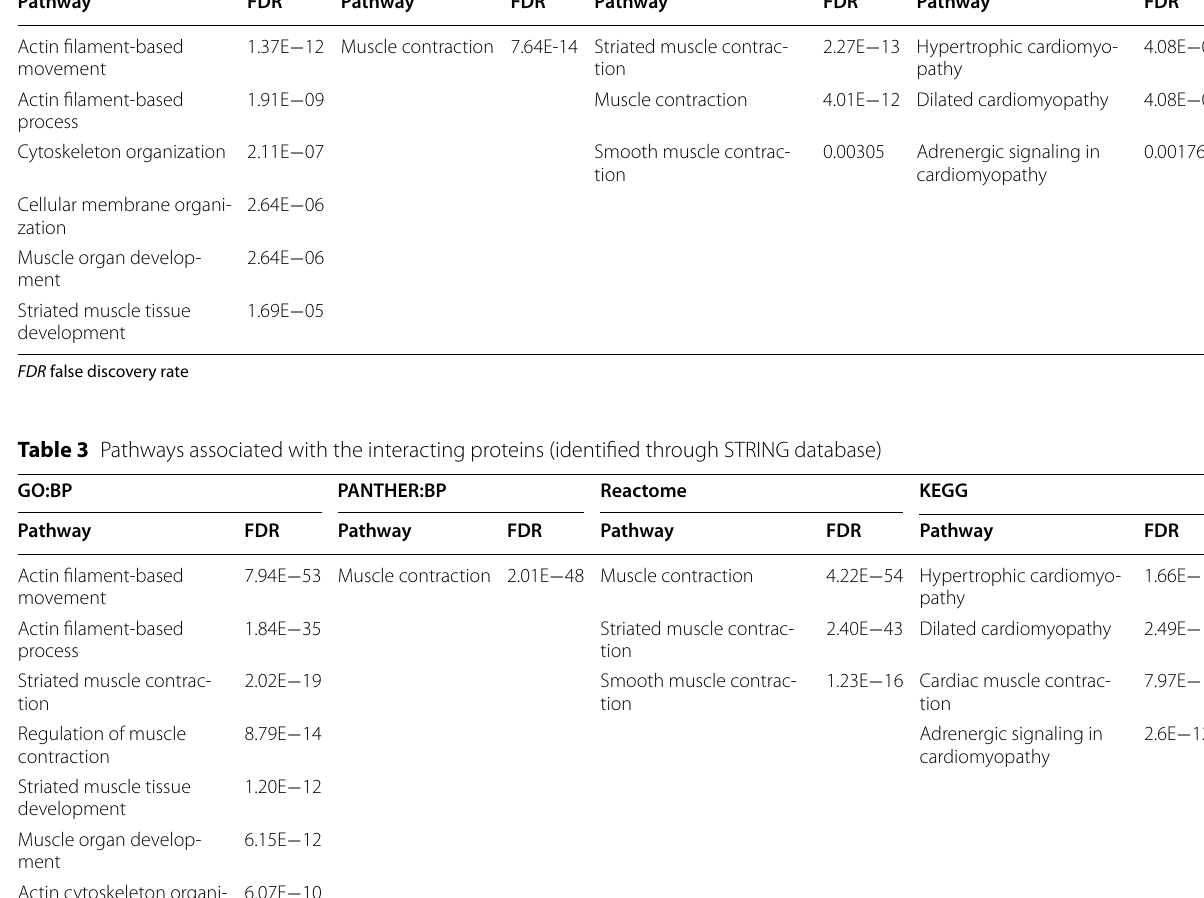
Table 2 Pathways associated with the interacting proteins (identified through IMEx database)